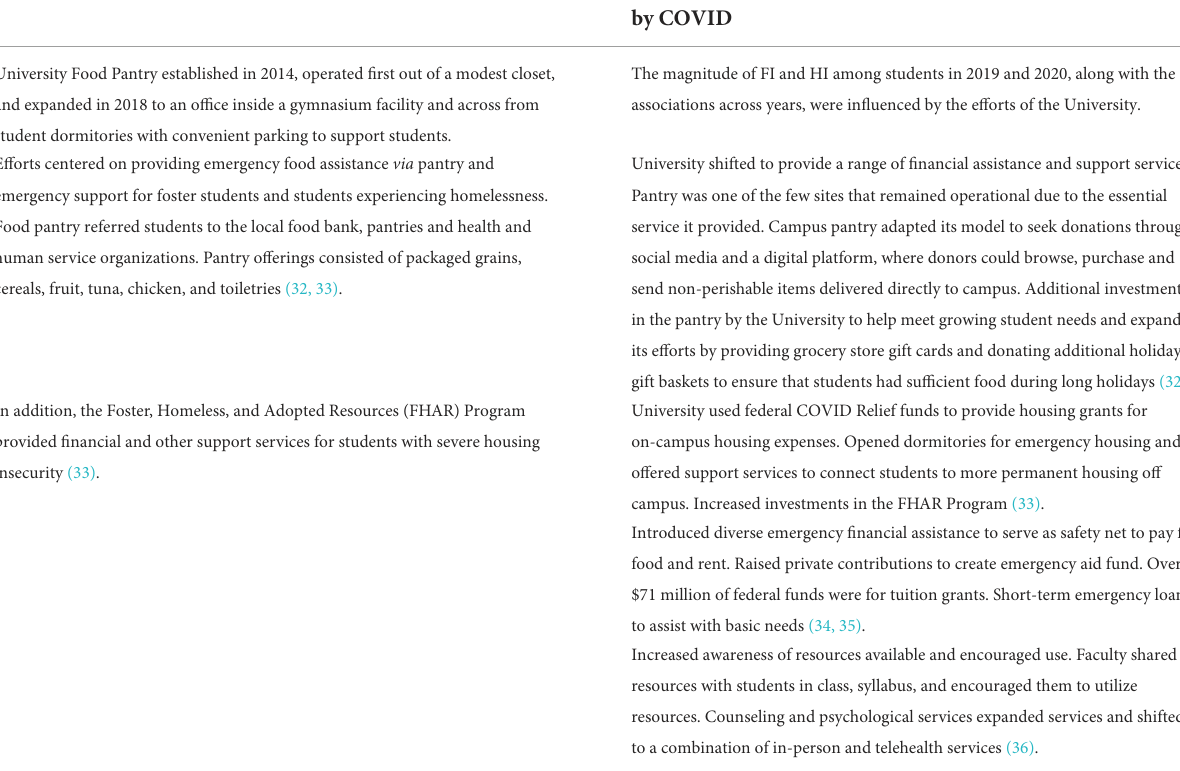
TABLE 4 University model to address food and housing